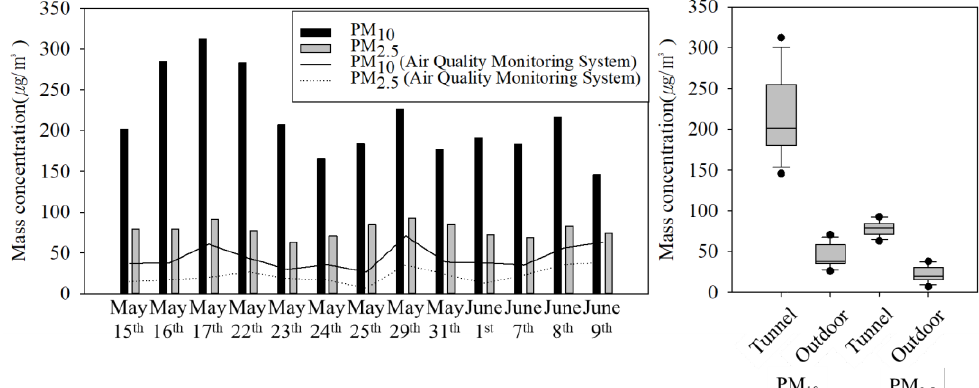
Figure 4. Particulate matter (PM) mass concentration in the subway tunnel at the M station.